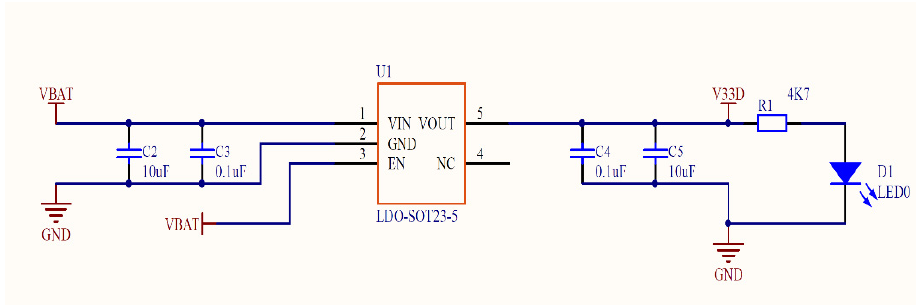
Figure 5. The circuit diagram of LDO-SOT23-5.